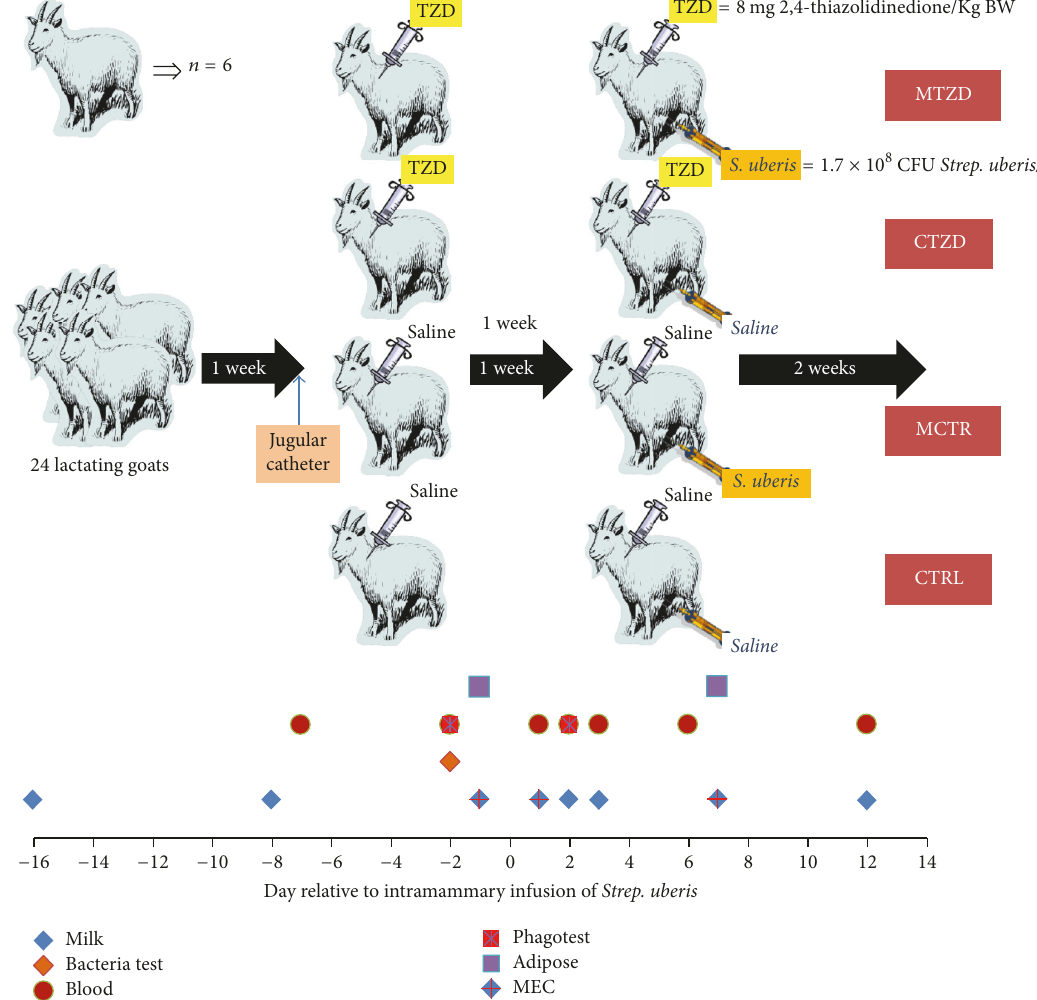
Figure 1: Overview of the experimental design with time points for collection of samples. MEC = mammary epithelial cell isolation.